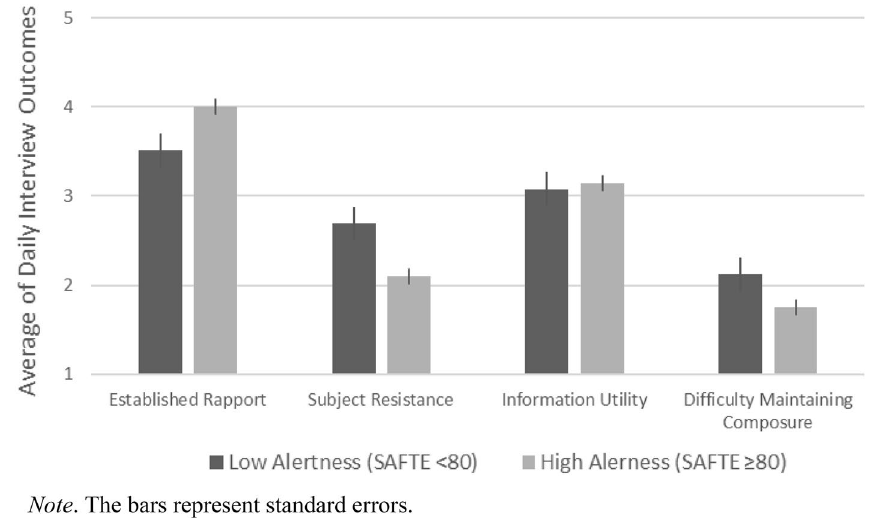
Figure 1. Mean differences in interview outcomes as a function of daily alertness